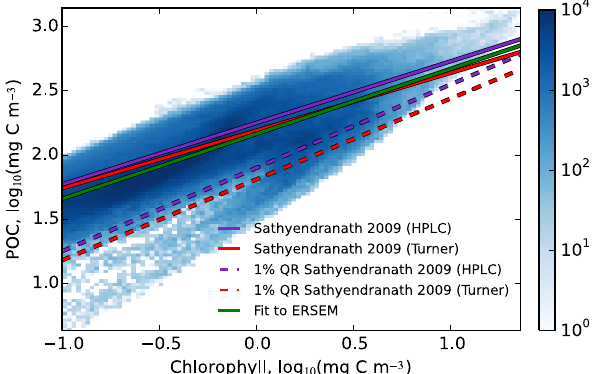
Figure 4. The ratio of particulate organic carbon to total chloro- phyll. The model data are shown as the logarithmically scaled two- dimensional data histogram distribution in blue scale. The full lines indicate the two Sathyendranath et al. (2009) fits to data, and a fit of the model to Eq. (6). The dashed lines show the two 1% quan- tile regression fit from the data and they indicate a theoretical lower bound for the modelled POC:Chl